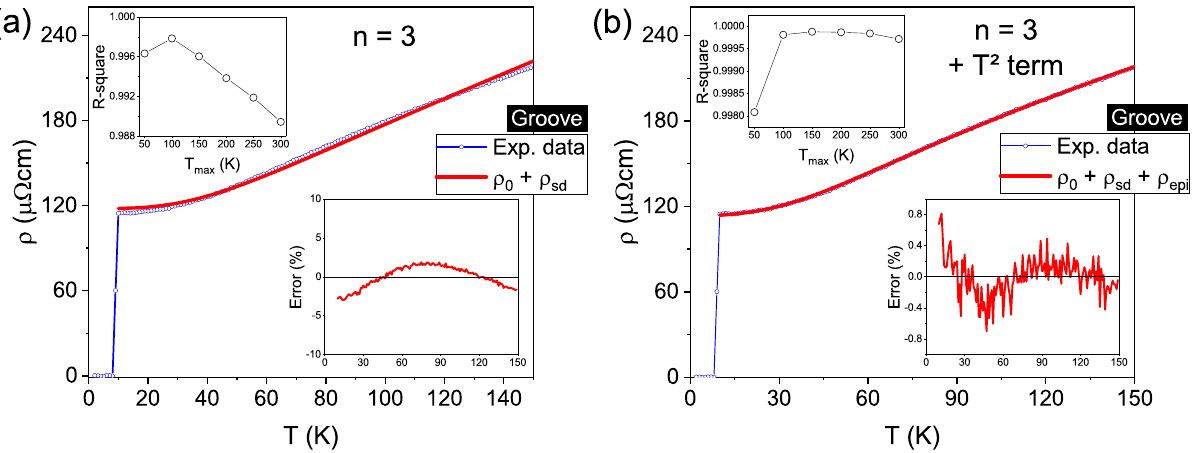
Figure 5. (Color online) Resistivity versus temperature (up to 150 K) curves for the groove. The fitting depicted by the red curve in ( a ) represents the sd band scattering ( n = 3), as described by Equation (4). In ( b ), the red curve represents the fitting considering an additional contribution given by Equation (5) in comparison to the fitting in ( a ). The lower inset in both panels represents the relative fit error and the upper insets shows the quality of the fit given by the R-square coefficient, which changes when the temperature upper limit is